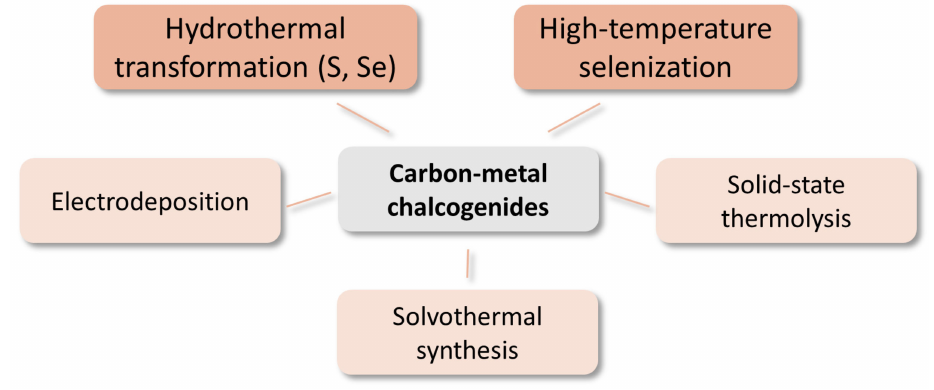
Figure 6. Graphical summary of synthesis methods of carbon–metal